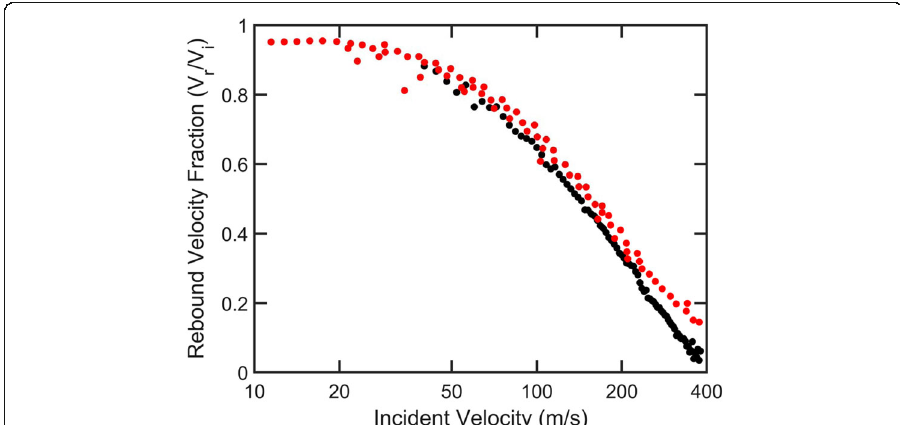
Fig. 13 Coefficient of restitution data for 510 nm PSLs at normal incidence on silicon, presented with incident velocity grouped in 4 m/s bins then averaged (mean), black circles. Any data outside of one standard deviation from the mean for each bin were removed. Created from 4348 measured events. The data are compared to data reported by Dahneke (red circles) in ref. [53] for 1.27 μ m PSLs at normal incidence on fused silica